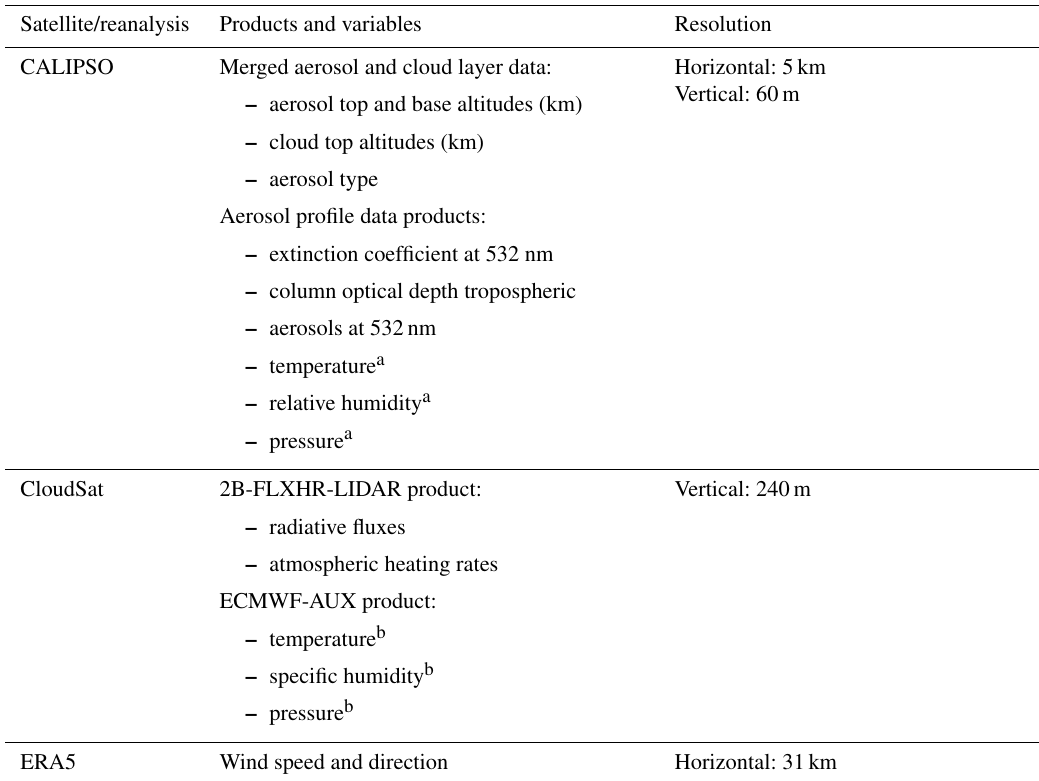
Table 1. Satellite data and models used in the study. Variables with a superscript “a” are derived from the Modern-Era Retrospective analysis for Research and Applications, Version 2 (MERRA-2) data product. Variables with a superscript “b” are derived from the European Centre for Medium-Range Weather Forecasts (ECMWF)